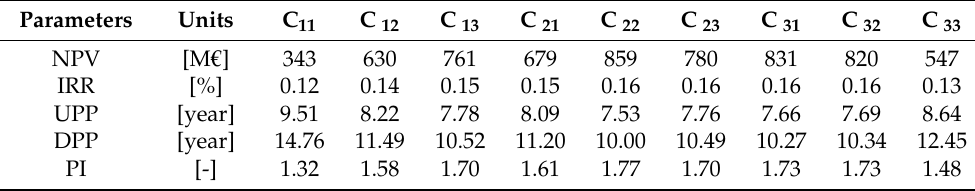
Table 17. The economic assessment of the CFPP system with 2-stages of membrane technology.